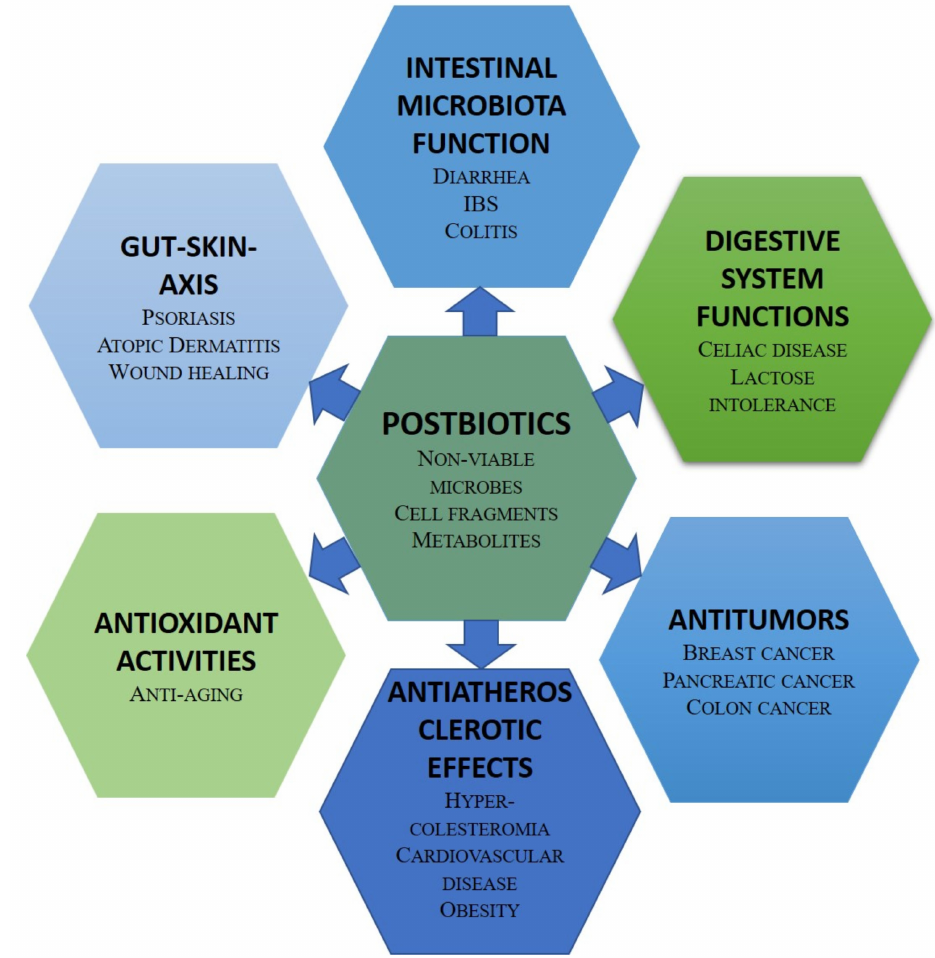
Figure 10. Potential applications of postbiotics in human